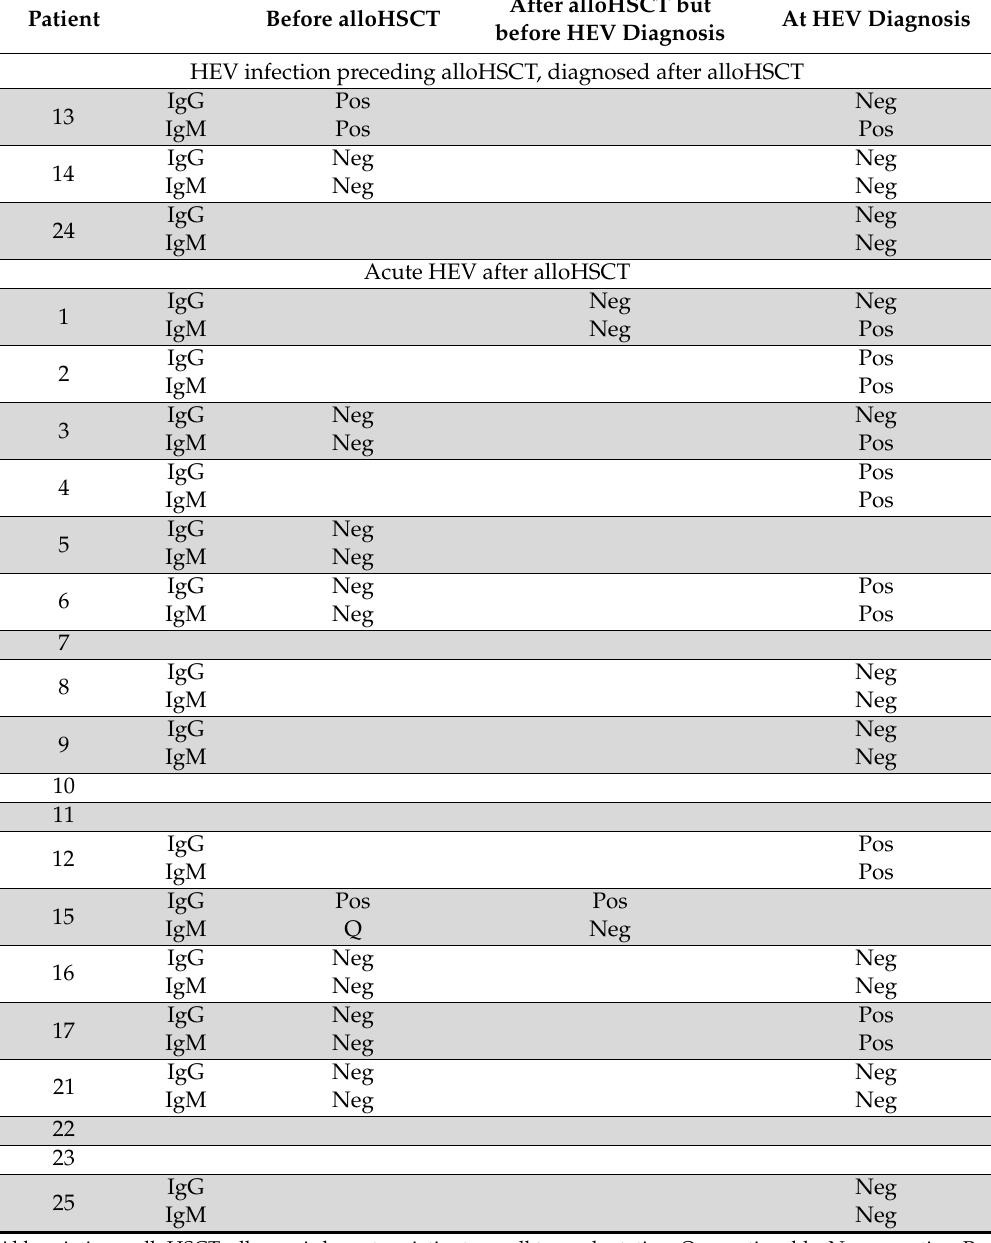
Table 3. Pattern of serology before and at HEV